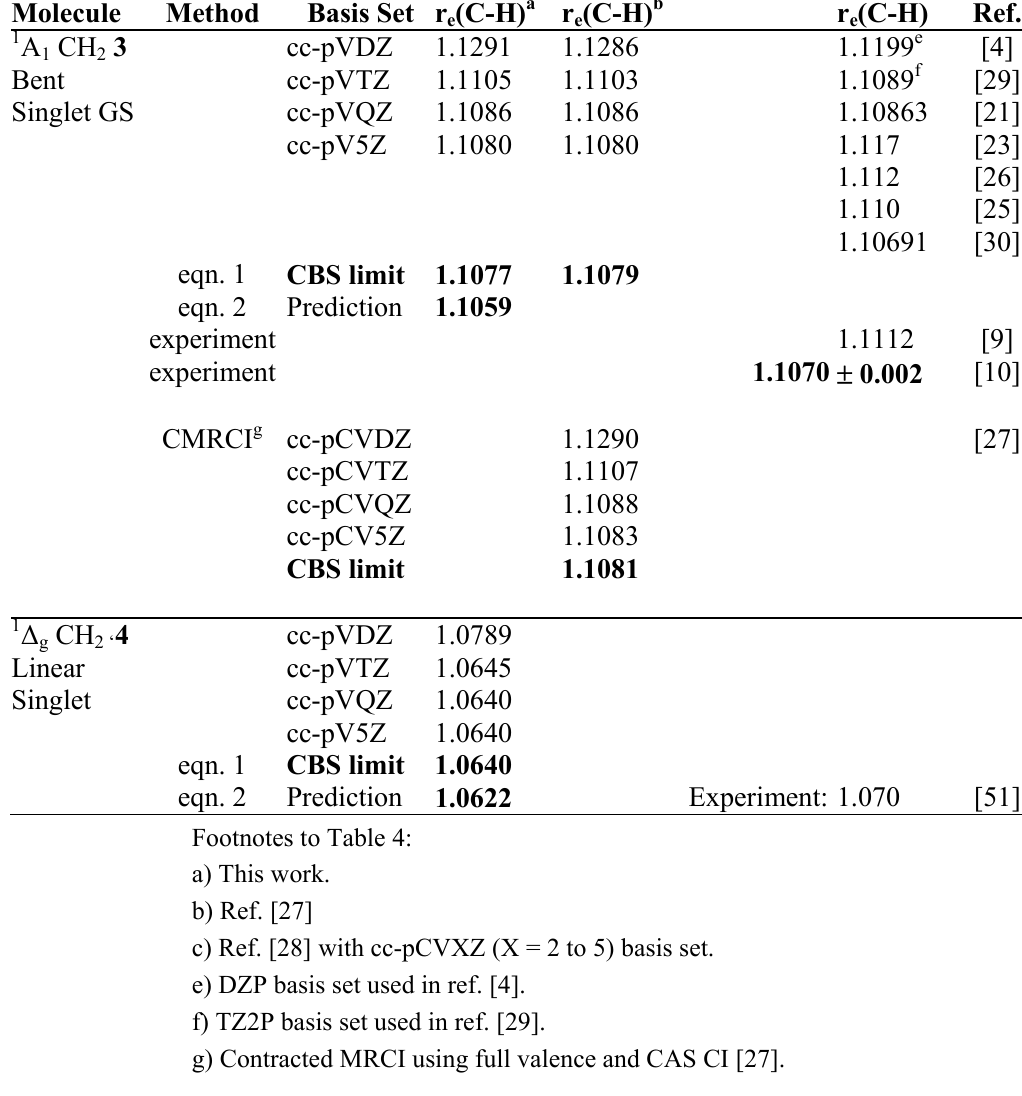
Table 4. Frozen-core by CCSD(T) and other post-HF methods calculated equilibrium (C-H) [Å] of singlet methylenes 3 and 4 in comparison to distances r e experimental and literature